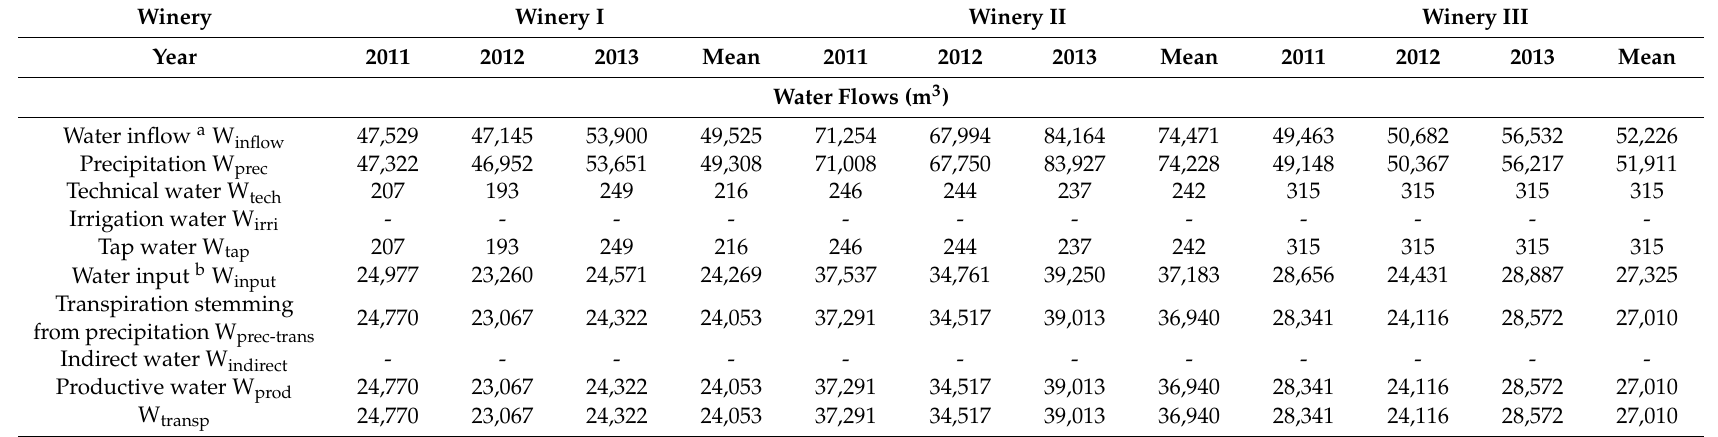
Table 5. Water input for Winery I, II, and